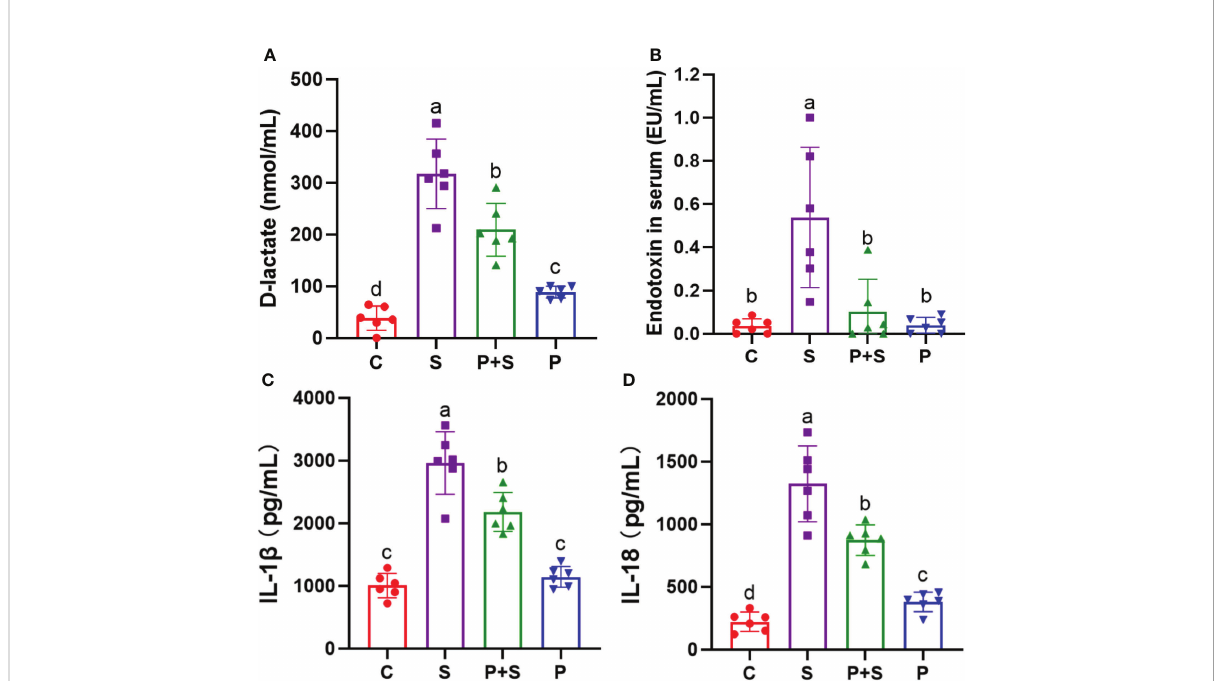
FIGURE 5 Determination of intestinal barrier function factors and immune function factors in chicken serum. The contents of (A) D-lactic acid and (B) endotoxin in chicken blood were determined by ELISA, which can re fl ect the state of intestinal injury. The contents of (C) IL-1 b and (D) IL-18 in chicken blood were measured by ELISA to evaluate the degree of in fl ammatory response. a, b, c, d: indicated the same item with different letters differ signi fi cantly ( P < 0.05).